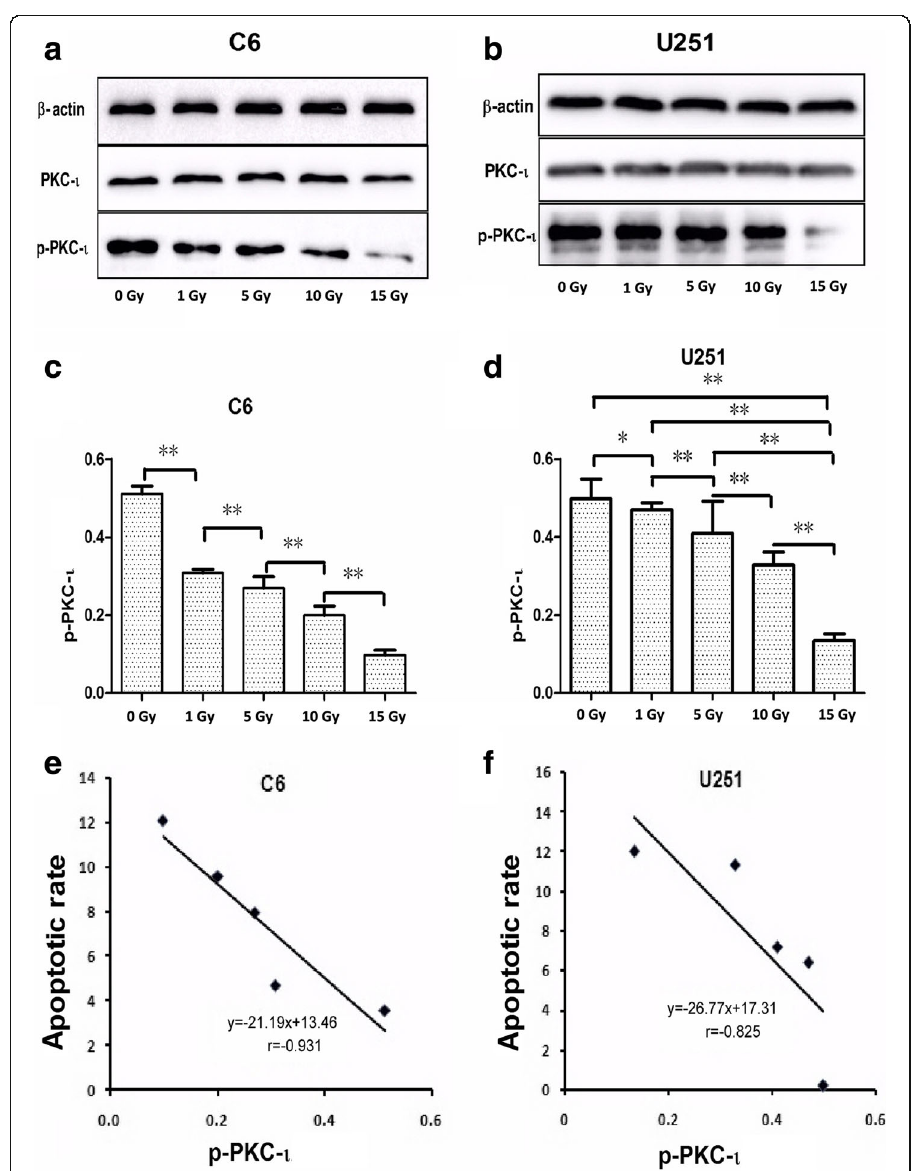
Fig. 3 The effects of X-ray irradiation on PKC- ι and p-PKC- ι expression levels. a and b – Photos of the western blot gels showing the PKC- ι and p-PKC- ι expression levels after C6 and U251 cells were exposed to X-ray irradiation at the indicated doses. c and d – Results for C6 and U251 showing thep-PKC- ι level normalized to total PKC- ι . The p-PKC- ι expression levels became lower with increasing X-ray irradiation. Statistical data were analyzed using SPSS 17.0. * p < 0.05, ** p < 0.01. e and f – Pearson correlation analysis was performed to determine the correlation between p-PKC- ι and apoptotic rate. A negative linear correlation was found. The linear correlation coefficients were determined as